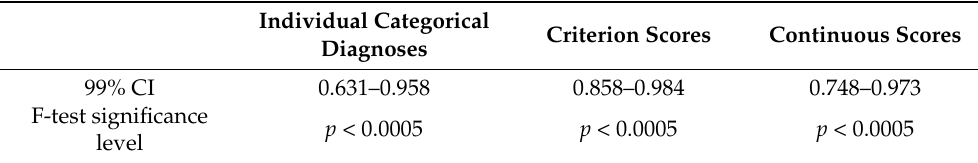
Table 3. Intra-class correlation coefficients computed for 99%